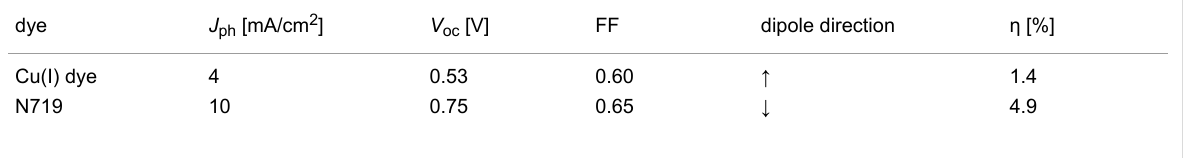
Table 1: I – V -characteristic values of a DSC sensitized with N719 or the copper(I)-based dye.